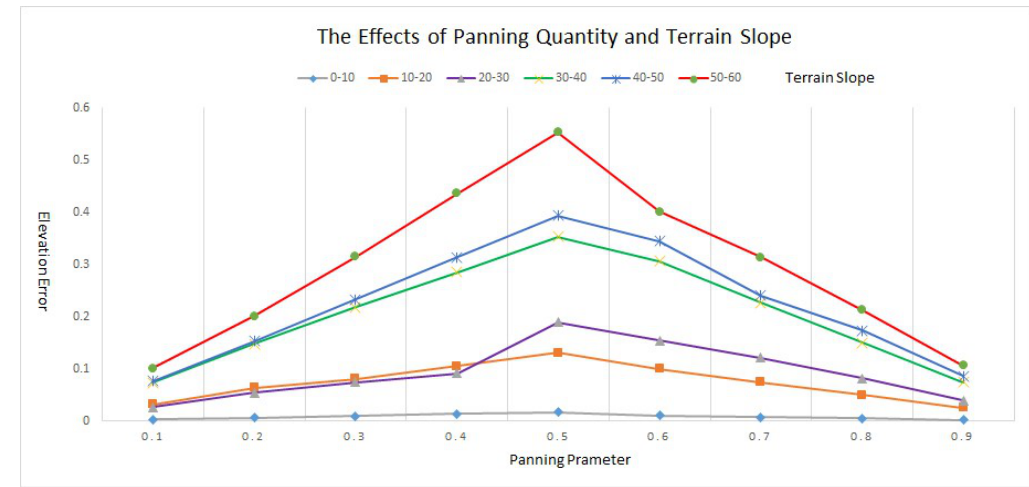
Figure 8. The statistics chart corresponding with Table